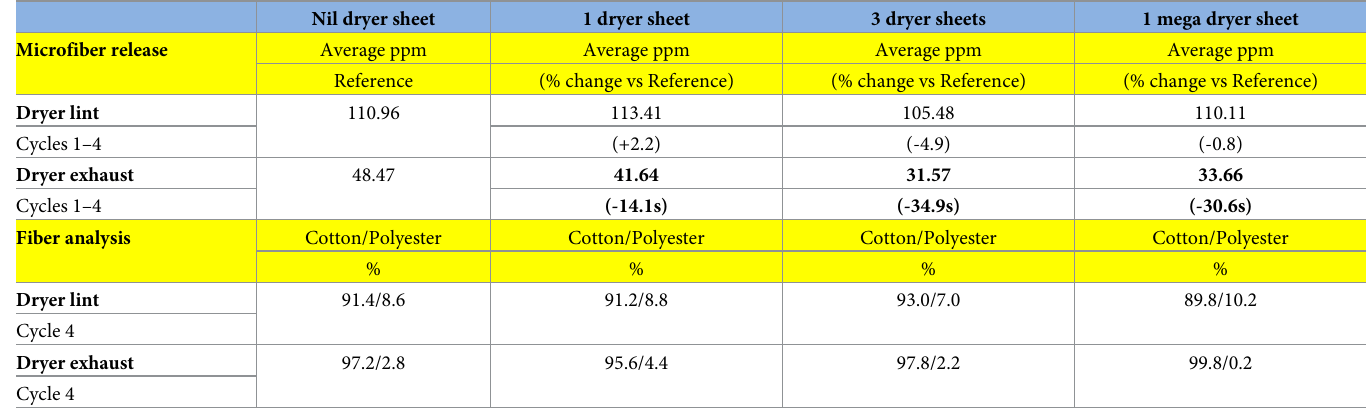
Table 4. Summary of microfiber release and fiber analysis data–North America dryer sheet testing.